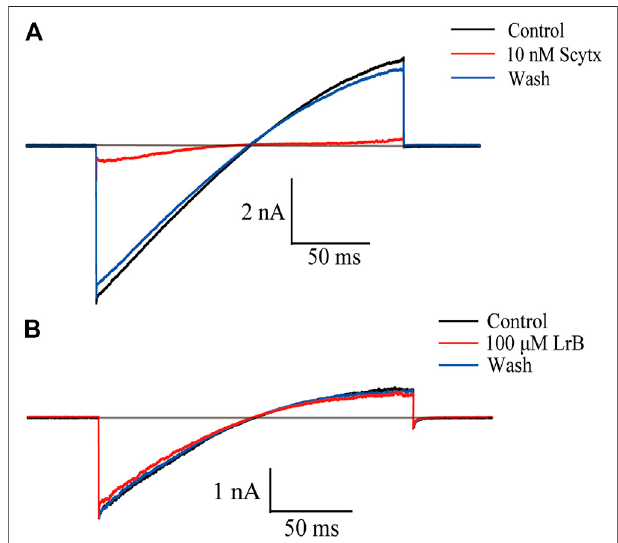
FIGURE 4 | Effects of LrB on SK Ca currents. (A) Representative whole- cell currents recorded in K Ca 2.2expressingHEK293T cellswithor without the treatmentof10 nM Scytx.Blacktracerepresentsthebaselinecontrolcurrent, red trace represents the currents recorded after Scytx treatment, and the blue trace is the current under external solution washing off Scytx. ( n (cid:2) 5). (B) Representative whole-cell currents recorded in K Ca 2.2 expressing HEK293 T cells with and without the treatment of 100 μ M LrB. Black trace represents the baseline control current, red trace represents the currents recorded after LrB treatment, and the blue one is the current under external solution washing off LrB ( n (cid:2) 5).